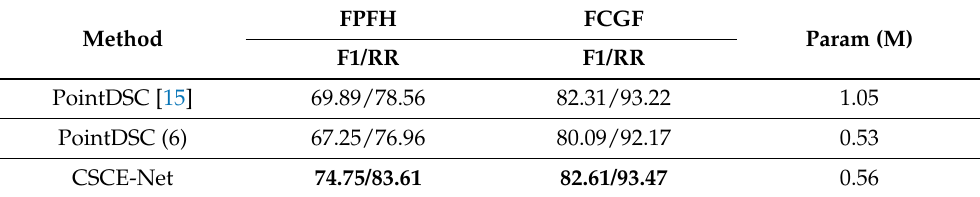
Table 7. Compare the network parameters (Param) of PointDSC and our CSCE-Net. PointDSC (6) indicates that the PointDSC feature embedding is reduced from 12 layers to 6 layers. The test results are combined with the 3DMatch